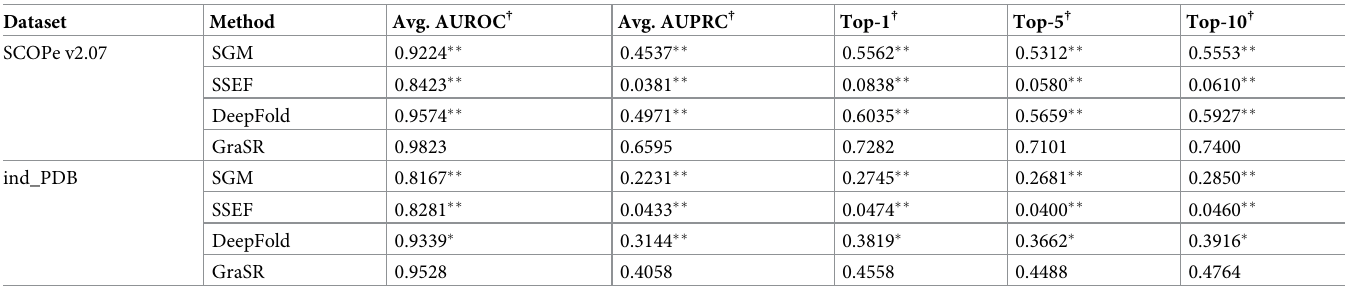
Table 2. Ranking performance of GraSR and other baseline